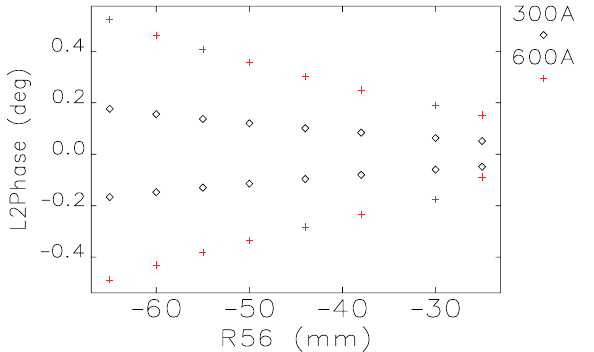
TABLE VI. Results of 300 randomized simulations with re- laxed tolerance levels for R 56 (cid:1) 2 65